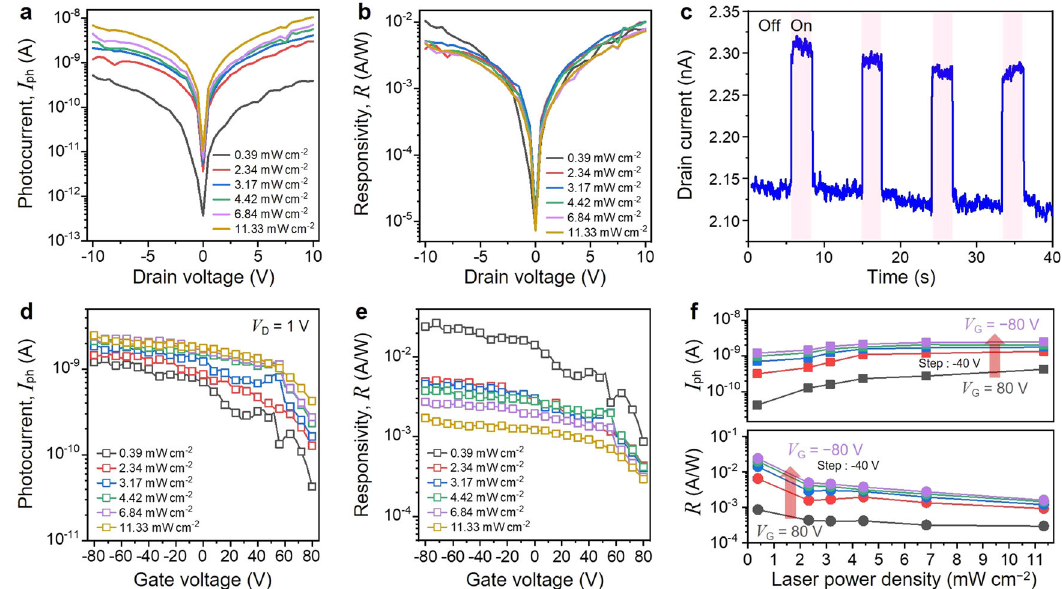
Fig. 3 Optoelectronic characteristics of the BP phototransistor under 1550 nm light source. a Photocurrent and b photoresponsivity under different power densities under zero gate bias condition. c Time-resolved photoresponse measured with P = 2.34 mW cm − 2 and V D = 1 V. The 1550 nm light source was repeatedly turned on and off for 3 s and 7 s, respectively. d Photocurrent and e photoresponsivity under different power densities for different gate voltages ( V D = 1 V). f Power-dependence of photocurrents and photoresponsivities for different gate voltages ( V D = 1